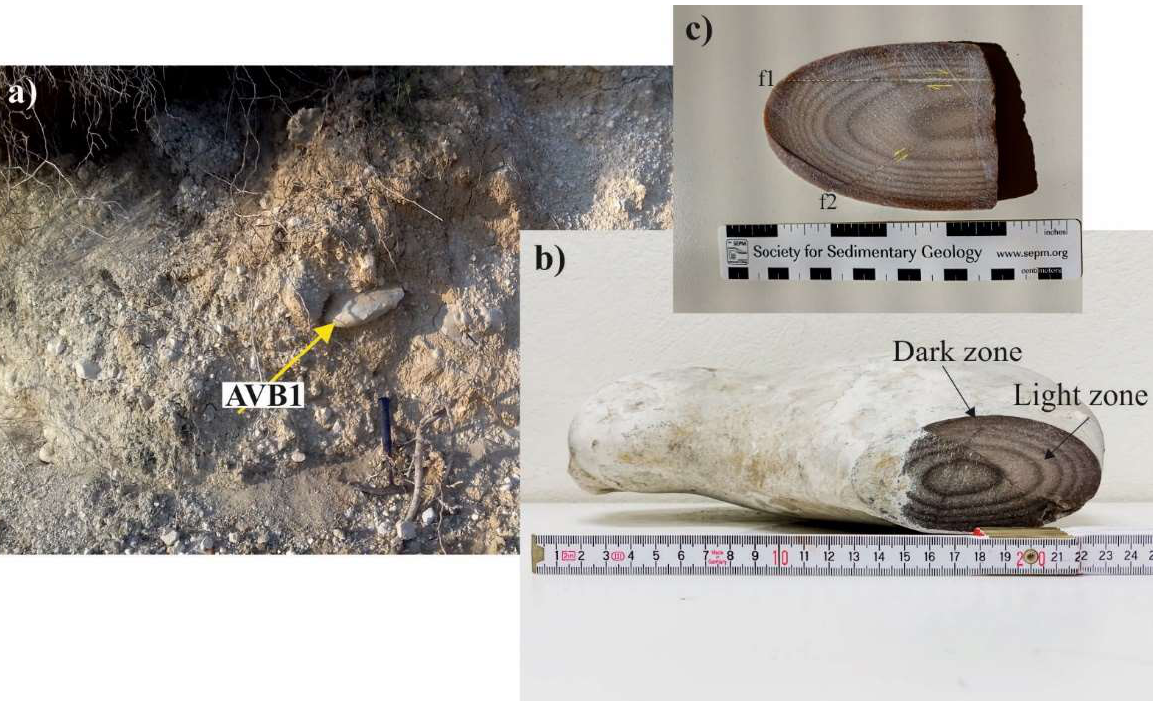
Figure 3. ( a ) Field view of the Avithos Beach sampling section; ( b ) macroscopical details of the AVB1 sample with the light/dark zonation and elliptical form; ( c ) detail of the nodule with microfaults (f1 and f2)